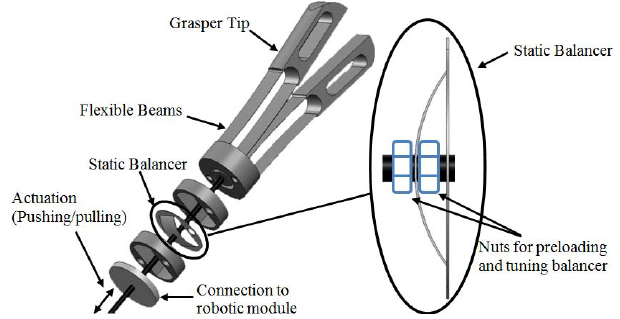
Figure 2. 3-D sketch of the SBCG at relaxed configuration.